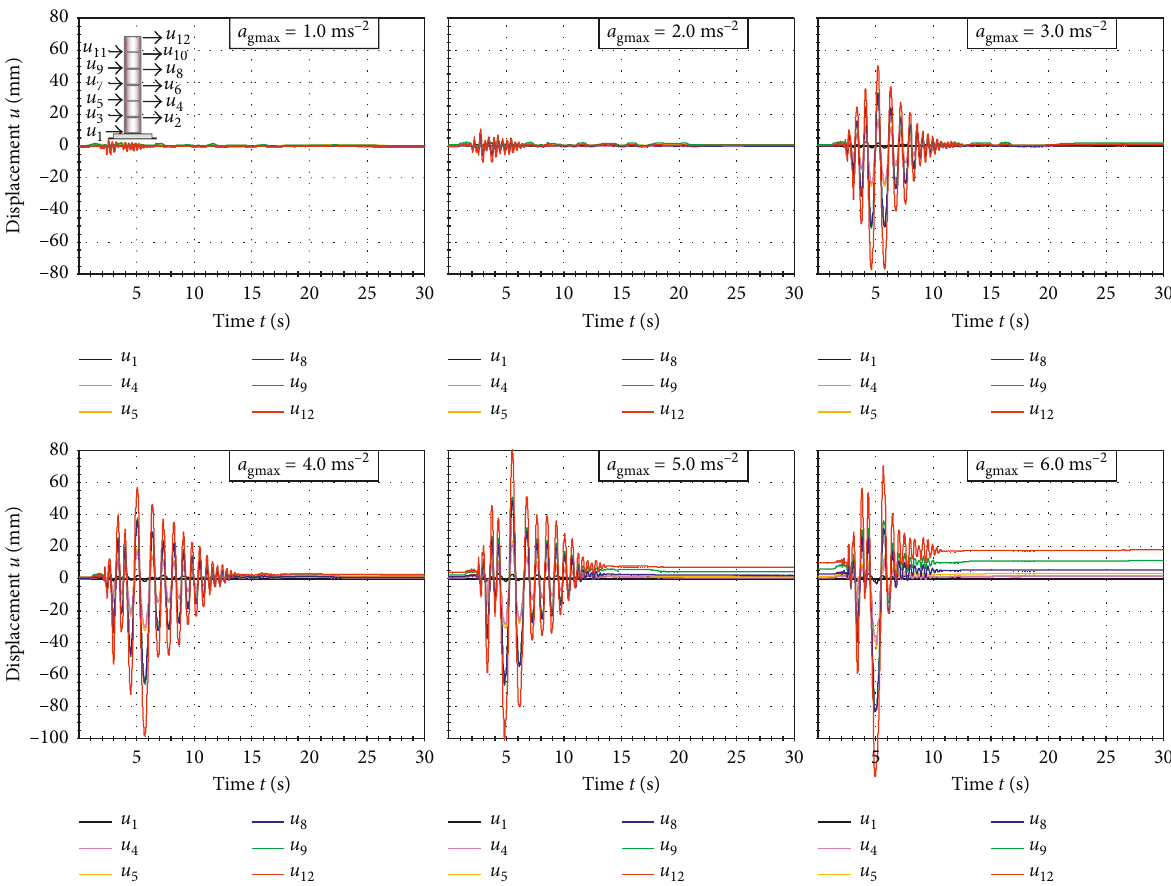
Figure 11: Horizontal displacements u 1 , u 4 , u 5 , u 8 , u 9 , and u 12 of the column S6 for the Ston accelerogram at some a gmax